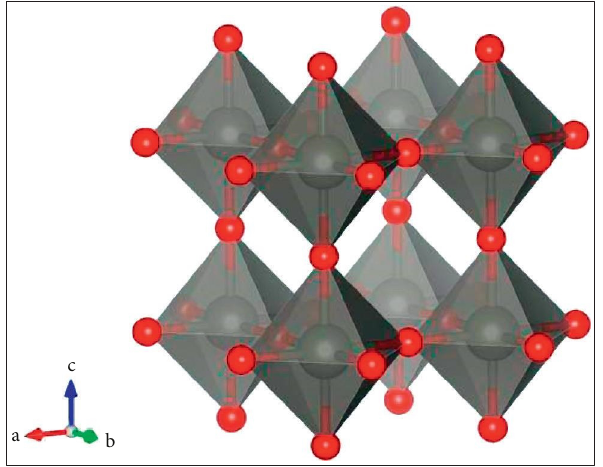
Figure 2: Crystal structure of monoclinic WO